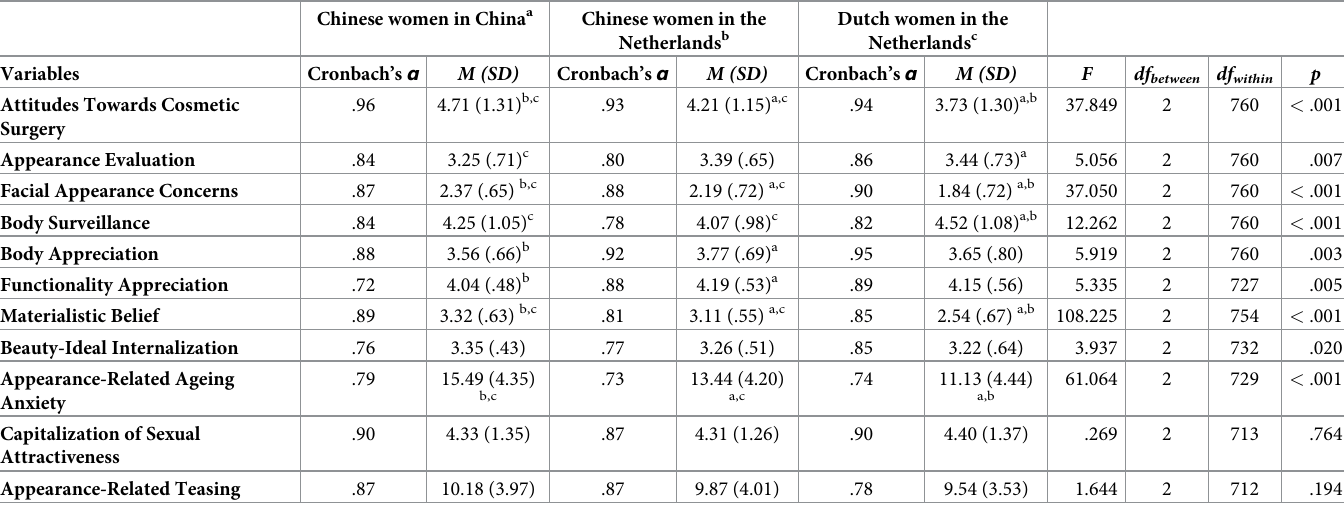
Table 2. Descriptive statistics for measured